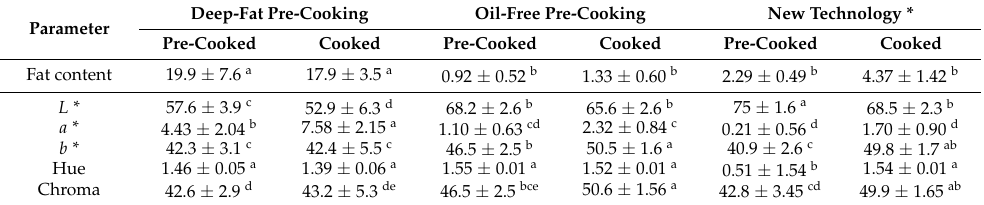
Table 1. Fat content (g 100 g − 1 ) and colour parameters of chicken nuggets pre-cooked with different methods. Different letters denote significant differences ( p < 0.05) among samples of the same row.